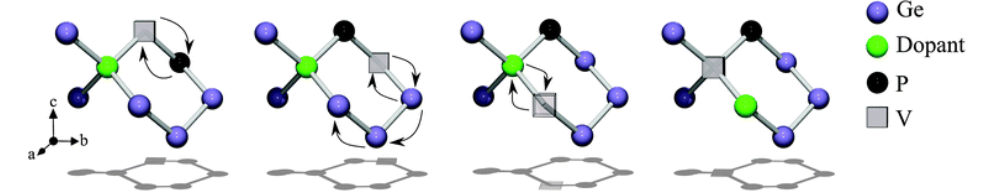
Figure 3. Diffusion of the P V pair via the ring mechanism of diffusion in the presence of an oversized Figure 3. Di ff usion of the P V pair via the ring mechanism of di ff usion in the presence of an oversized dopant atom. Reproduced by permission from the PCCP Owner Societies [54]. dopant atom. Reproduced by permission from the PCCP Owner Societies